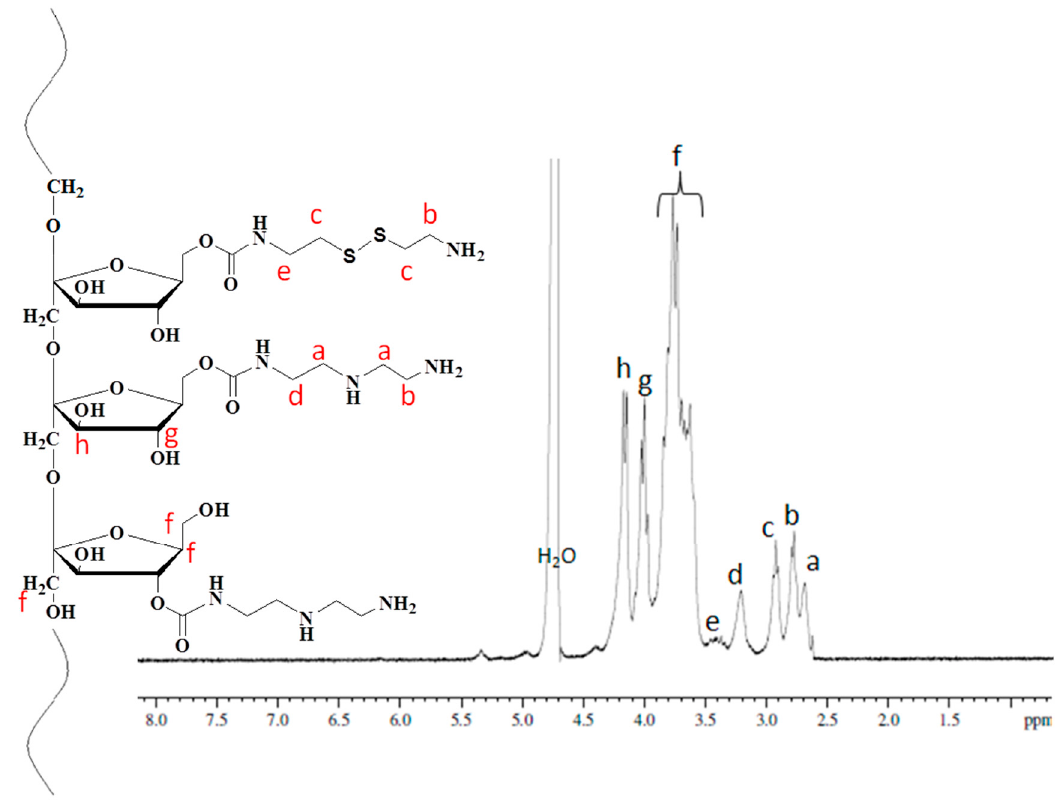
Figure 1. Representative 1 H-NMR spectrum of INU-C-DETA in D 2 O.